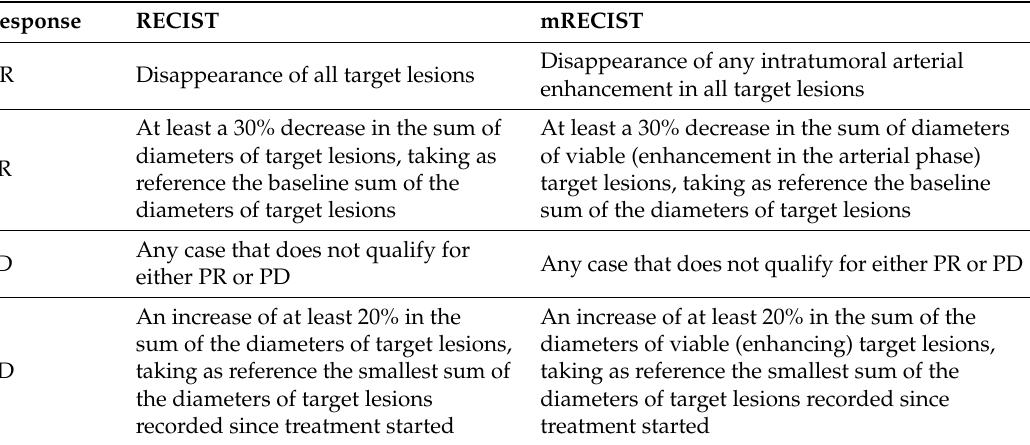
Table 2. Assessment of target lesion response: Conventional RECIST vs. mRECIST for HCC following the AASLD-JNCI guideline